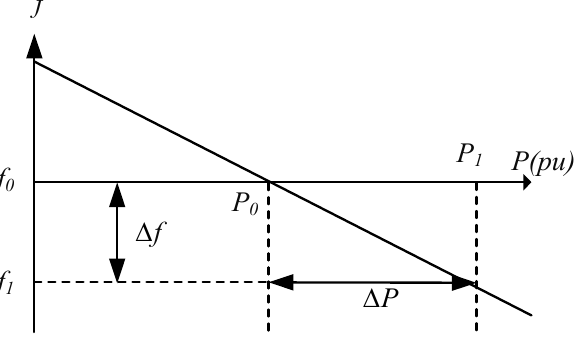
Figure 1. Conceptual illustration of droop